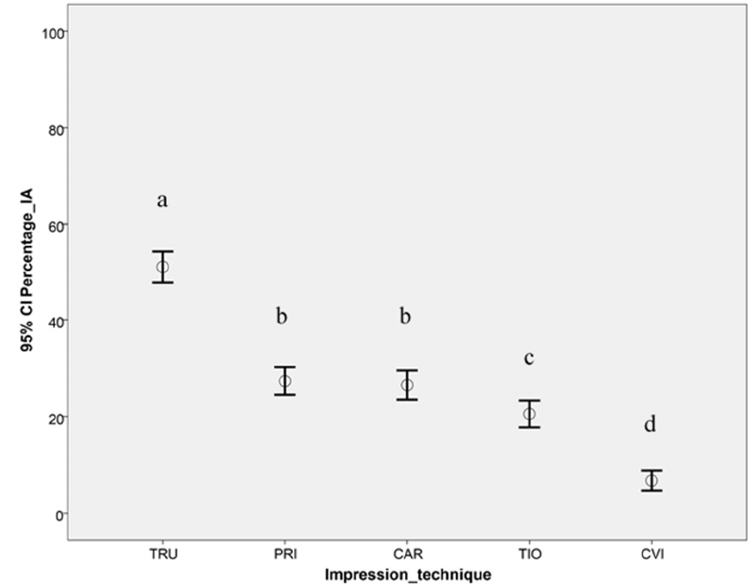
Figure 5. The 95% confidence interval of the displayed interdental area [%] for the five impression techniques (different letters denote significant differences).